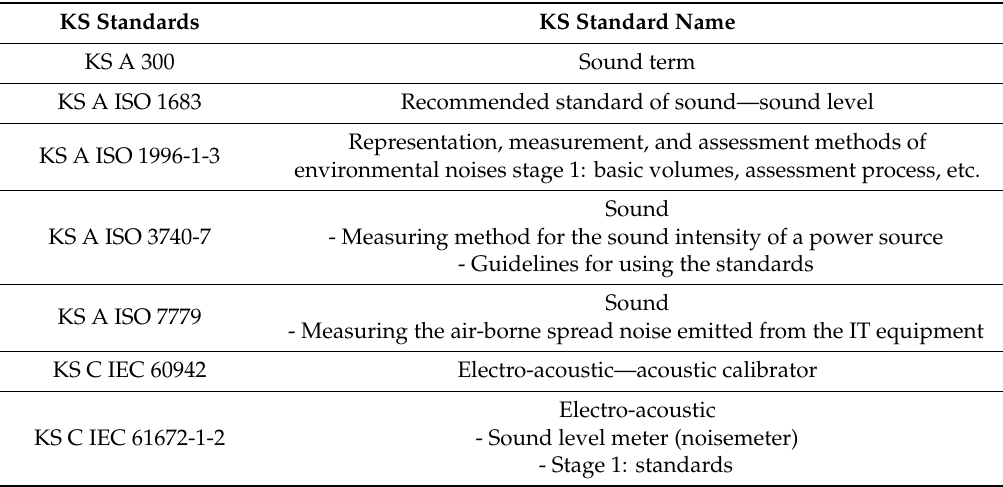
Table 2. Noise measurements and standardization.